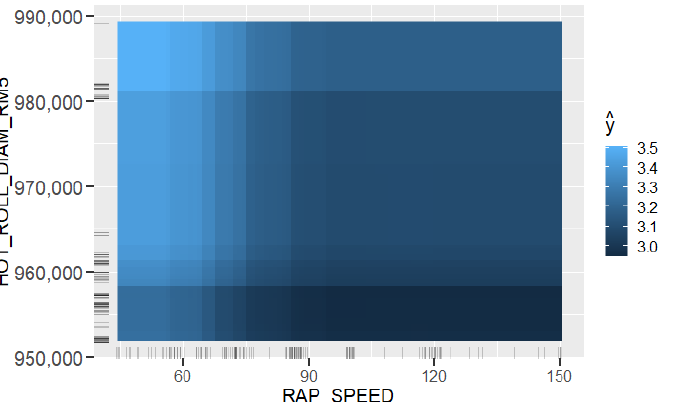
Figure 13. PDP of the roughness and the interaction of the diameter of the roll at the fifth roughing mill pass and the speed of the RAP